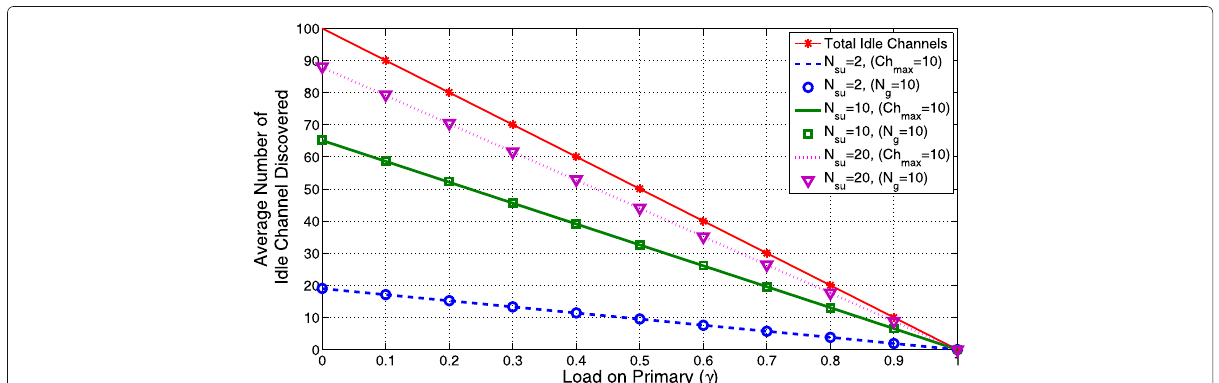
Fig. 9 Comparison of average number of idle channels discovered by SUs when ch max = 10 and N g =